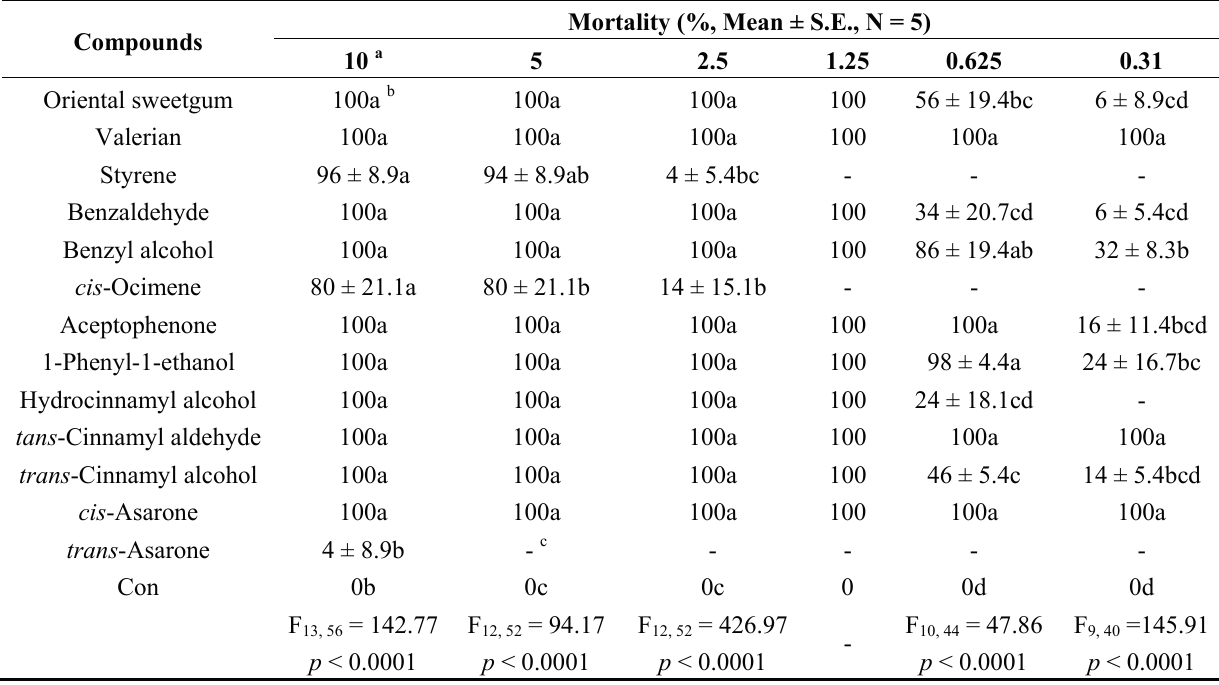
Table 3. Fumigant antitermitic activity of oriental sweetgum and valerian essential oils and their components against Japanese termites at 7